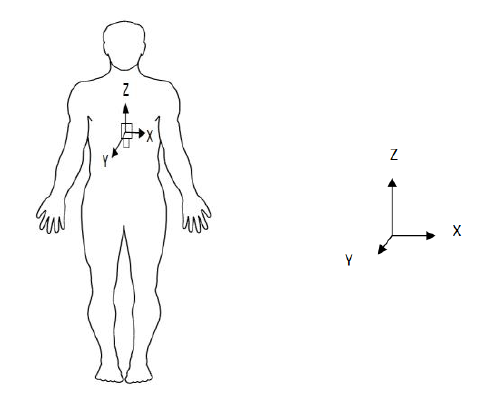
Figure 5. The antenna location and orientation for on-body radiation